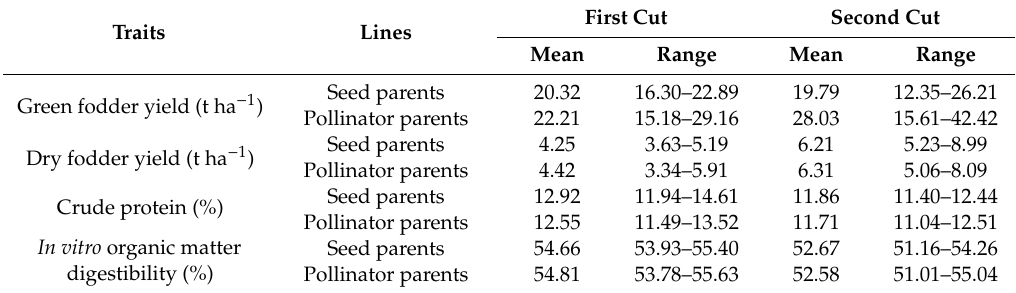
Table 2. Mean and range of forage traits of 116 hybrid parents from 2 years mean data (summer 2015 and